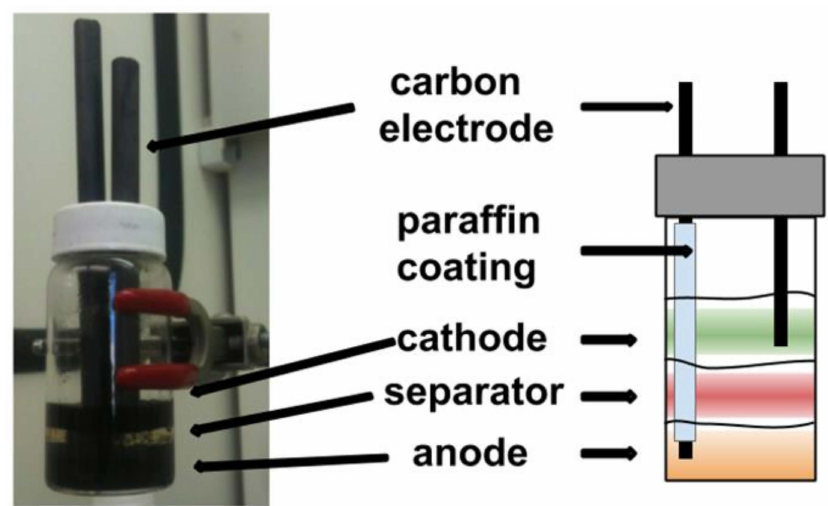
Figure 3. Gel Leclanch é –graphite cell constructed in a 20 mL